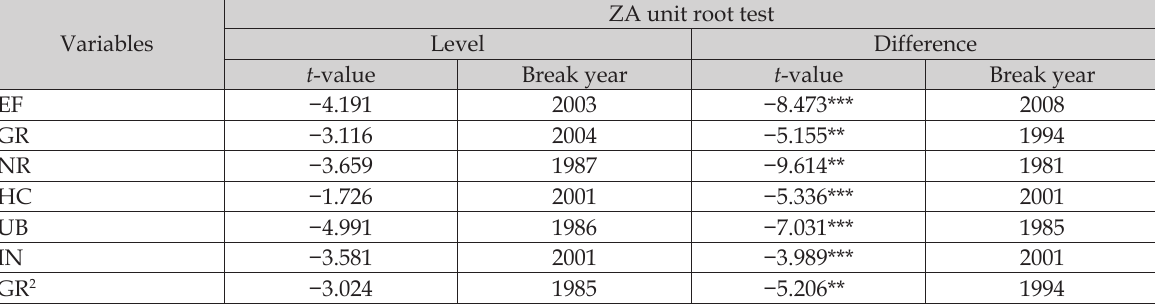
Table 5. ZA unit root results.